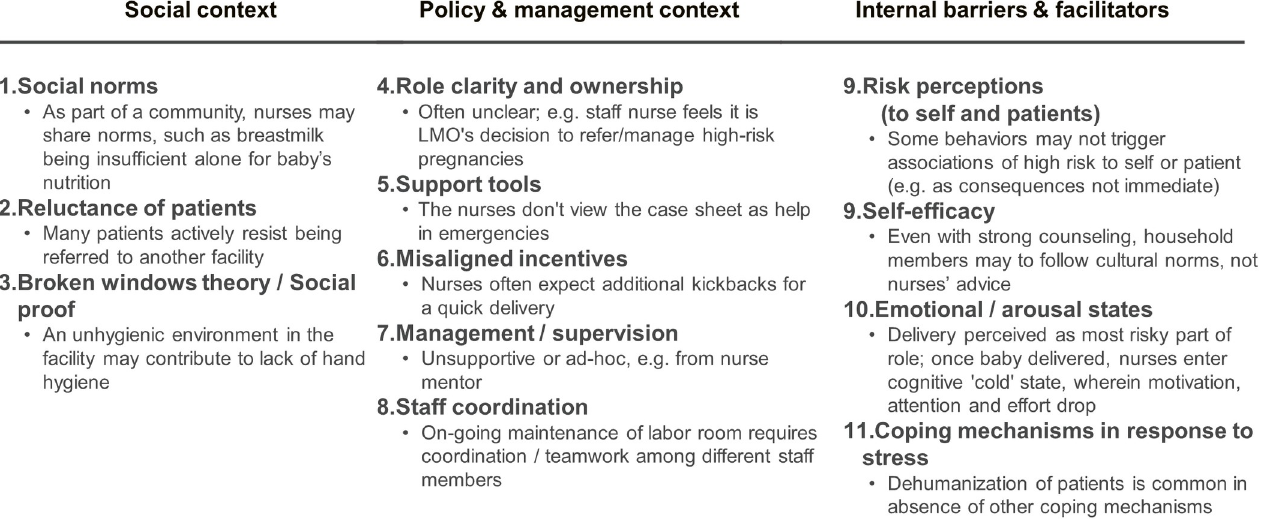
Fig 4. The 12 focus areas identified as likely to drive critical behaviors of staff nurses in facilities. These 12 factors were selected out of 17 found in total, based on the frequency with which they occurred in facility-based immersion interviews.